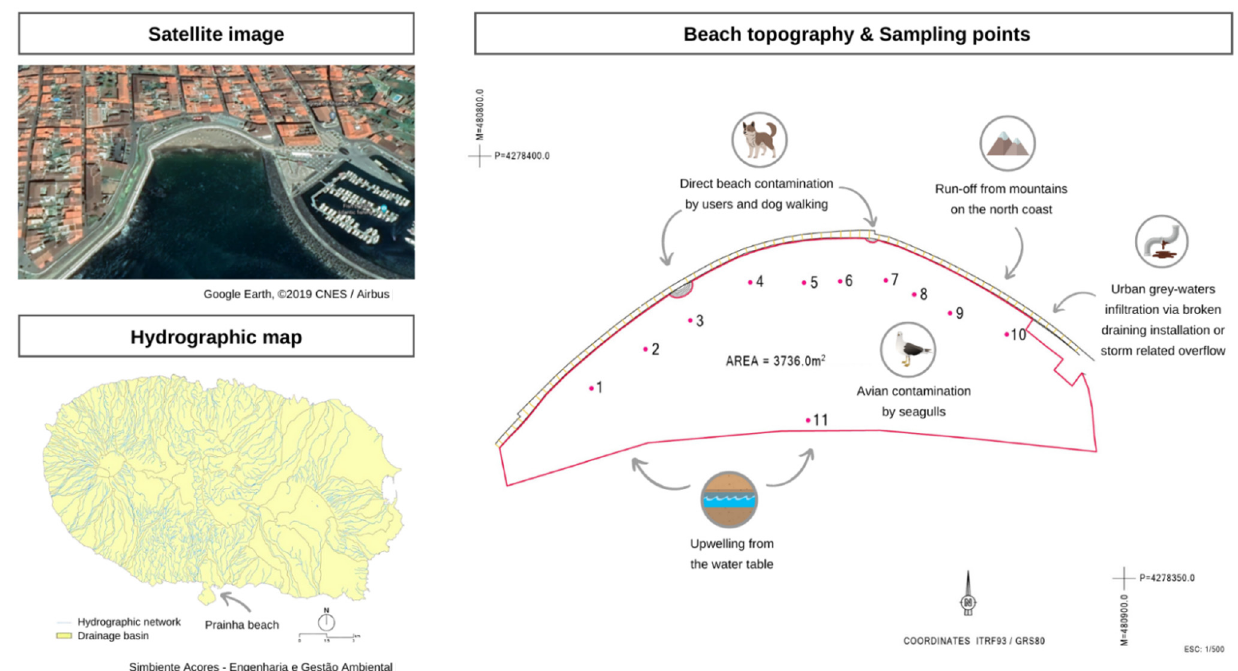
Figure 1. Prainha beach—satellite image from Google Earth, ©2019 CNES/Airbus [48] and topography with an indication of the sampling sites 1 to 11 (supplied by the municipality). The hydrographic map of the island is also included to show the possible runoffs that could have an impact on the beach [49].